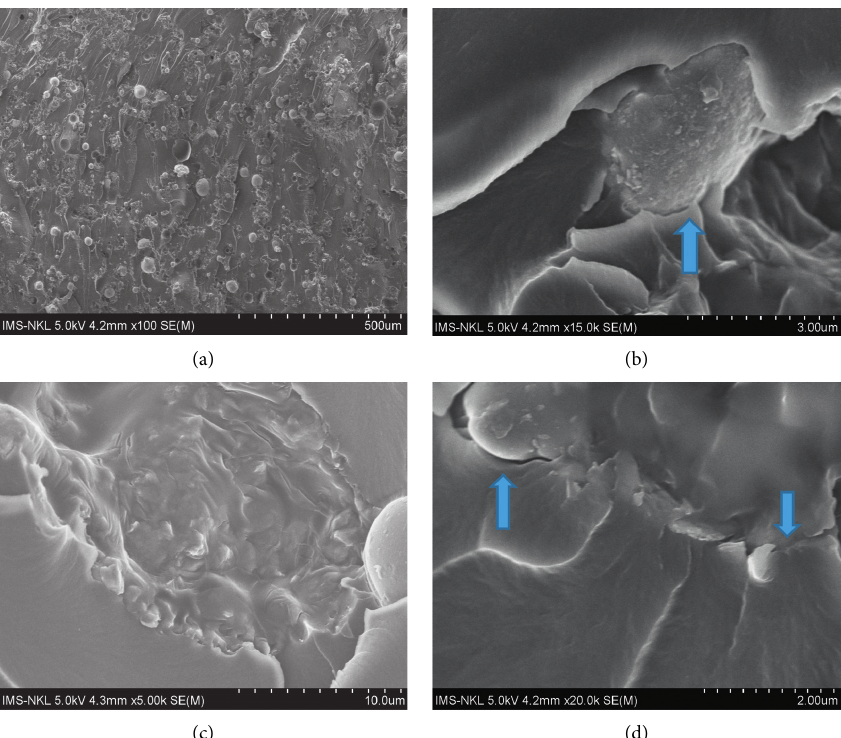
Figure 5: SEM image of the broken surface of the nanocomposite: 40 parts by weight of bat ash and 3% by weight of nanoclay. Table 6: Results for flammability tests (reaction to small flame) oxygen index (OI) and UL 94 for nanocomposites. Sample code